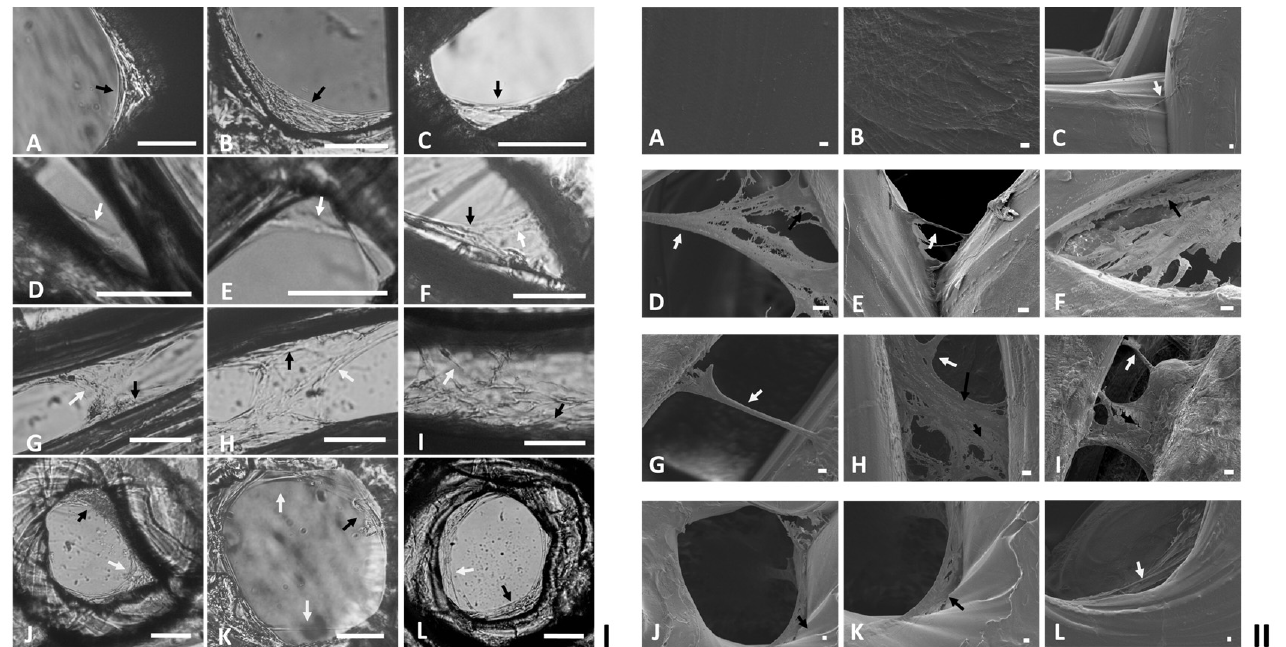
Figure 6. Micrographs of HDFs cultured on PLA discs with finely controlled corners, gaps or circular open pores. Aliquots of 50 µ L HDFs (10 6 cells/mL) were seeded on the top surfaces of PLA discs for 1 h for firm cell attachment, then cultured in 1 mL DMEM media for 40–60 days and analyzed via ( I ) PCM (scale bars = 100 µ m), or ( II ) SEM (scale bars = 10 µ m). Cells colonized the regular open structures via cell bridging (White arrows) or cell-stacking (Black arrows) strategies are highlighted.